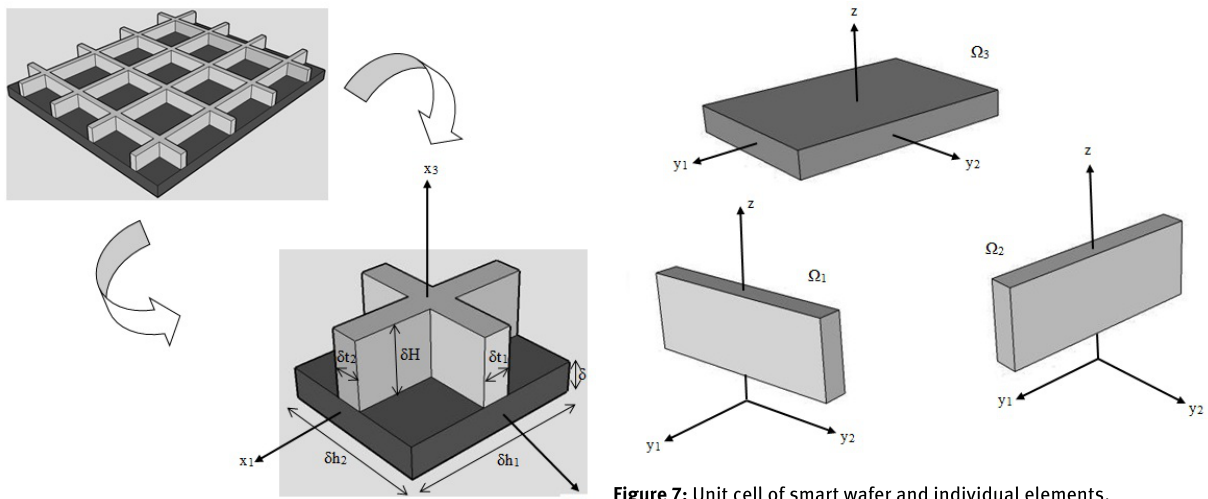
Figure 7: Unit cell of smart wafer and individual